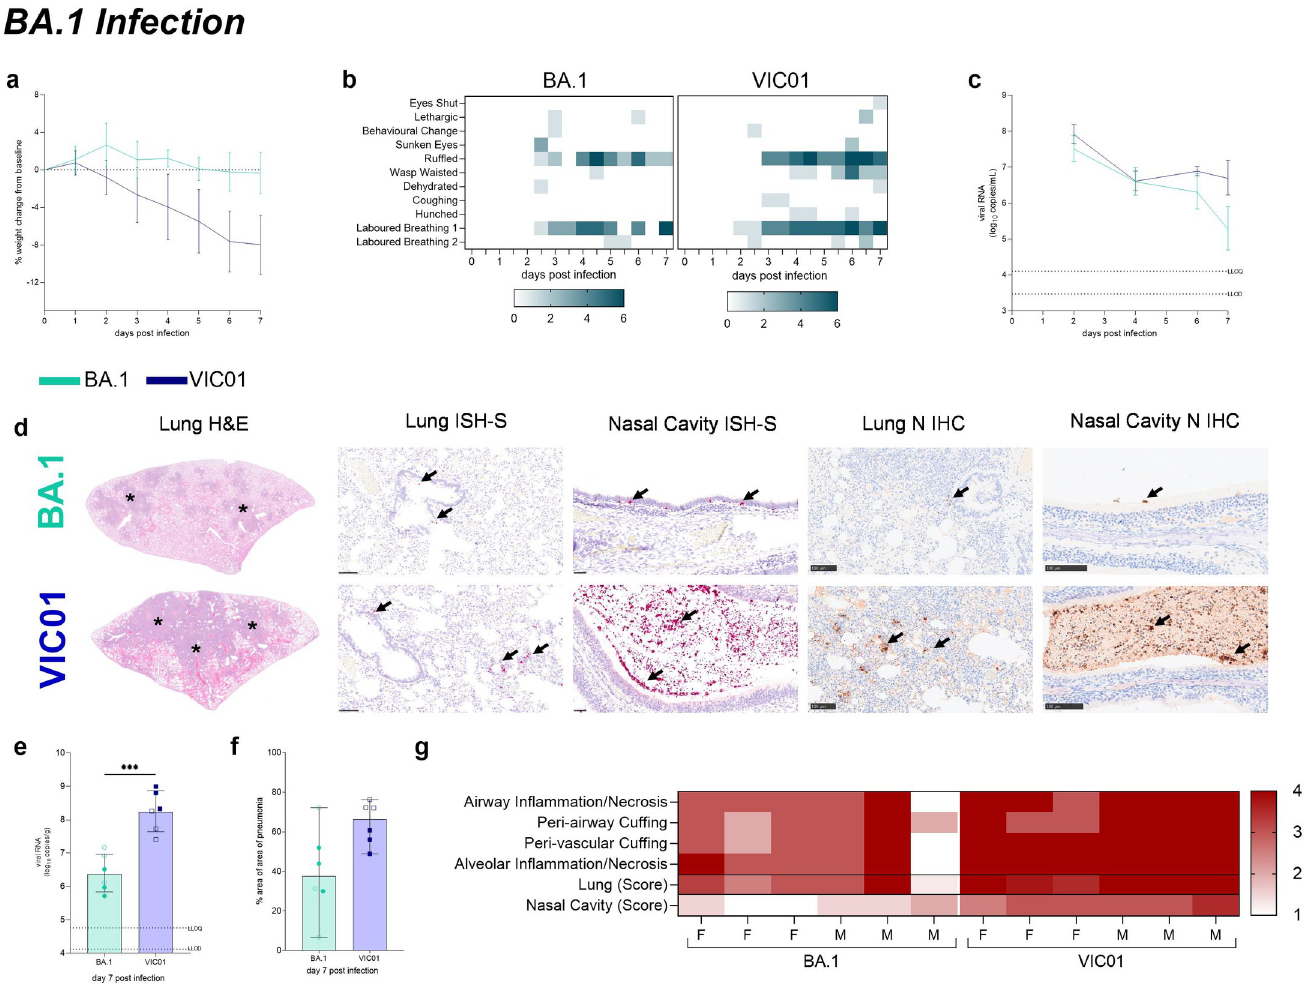
Fig 3. BA.1 Infection Study Hamsters were monitored for ( a ) weight change. Hamsters infected with VIC01 experienced significantly (P = 0.0327 at day 2) more weight loss from day 2 onwards than hamsters infected with BA.1. Lines show group means, error bars show standard deviation. ( b ) Heatmaps illustrate the frequency of each clinical sign. The darker the square the more hamsters that were recorded with that clinical sign. Clinical signs observed in BA.1 infected hamsters had a lower frequency than those observed in VIC01 infected hamsters. Throat swabs were collected at days 2, 4, 6 and 7 to assess shedding from the URT. ( c ) Total viral RNA was quantified by RT-qPCR at all sample timepoints. Lines show group means, error bars show standard deviation. There was a significant difference in the total amount of viral RNA shed at both day 6 (P = 0.0301) and day 7 (P < 0.0001) post infection between BA1 and VIC01 infected hamsters. Statistical analysis between groups was carried on log base -transformed data using RM-ANOVA. The dashed horizontal lines show the lower limit of quantification (LLOQ) and the lower limit of detection (LLOD). Following necropsy Pathological examination ( d ) showed differences between hamsters challenged with VIC01 compared to those challenged with the BA.1 variant in the lung by H&E staining and in-situ hybridisation in the lung (bar = 250 μ m) and nasal cavity (bar = 100 μ m). Immunohistochemistry (IHC) staining for N protein was also carried out in both lung (bar = 100 μ m) and nasal cavity (bar = 100 μ m). ( e ) viral load was quantified in the lungs of hamsters. Hamsters challenged with VIC01 had significantly higher viral load in their lungs than hamster challenged with BA.1(P = 0.0068). Bars show group means and error bars show standard deviation. The dashed horizontal lines show the lower limit of quantification (LLOQ) of the assays. Statistical analysis between groups was carried out using an unpaired T test. Assessment of the lung revealed significantly (P = 0.0329) more ( f ) pneumonia in VIC01 infected hamsters than in BA.1 infected hamsters. Statistical analysis between groups was carried out using an unpaired T test. ( g ) Pathology scores assigned to each hamster are illustrated in a heatmap. Higher pathology scores were observed in hamsters infected with VIC01 in both the lung and nasal cavity. https://doi.org/10.1371/journal.ppat.1011293.g003 infected animals (S4 Fig). Cell necrosis was observed in the respiratory and olfactory epithe- lium associated to inflammatory exudates within the nasal cavity luminae and the presence of virus RNA (Fig 3D), showing significantly less pathology and virus RNA in the epithelial cells and exudates in the BA.1 infected animals compared to the VIC01 infected animals (Fig 3I).